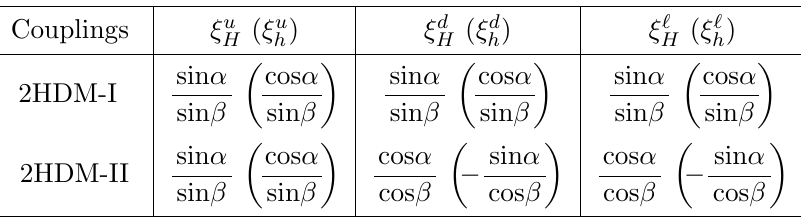
Table 1 . Yukawa couplings (cid:24) f ( (cid:24) f ) between the heavy Higgs boson H 0 (light Higgs boson h 0 ) H h and the SM fermions are shown for the 2HDM-I and 2HDM-II, where a common factor m f =v (corresponding to the SM Higgs Yukawa coupling) is factorized